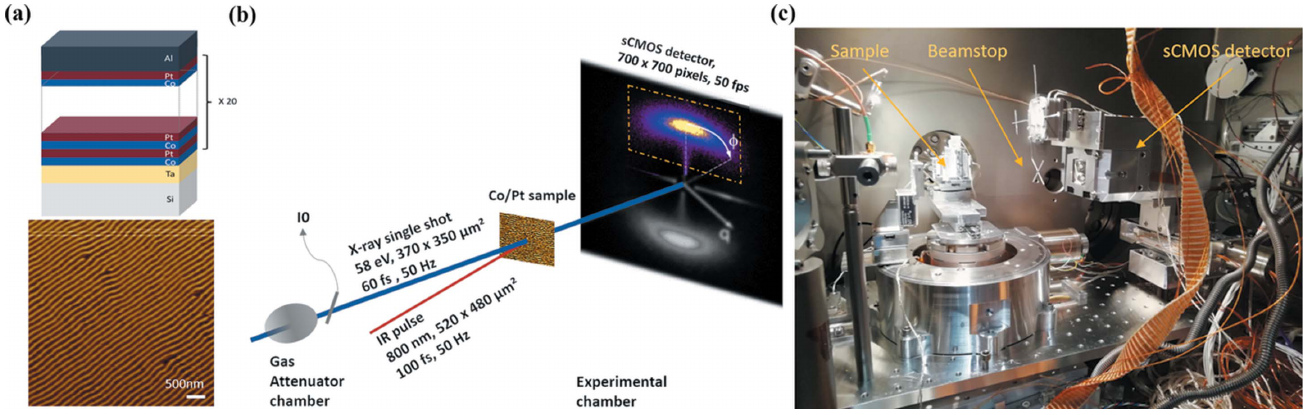
Figure 1 ( a ) Sketch of the multilayer composition exhibiting out-of-plane magnetic anisotropy. A magnetic domain structure exhibiting aligned stripe domains at remanence is shown by the magnetic force microscope (MFM) image (5 m m (cid:2) 5 m m) obtained using an in-plane demagnetization procedure. ( b ) Scheme of the pump–probe experiment performed in transmission geometry. ( c ) Photograph of the CMOS setup at the DiProi